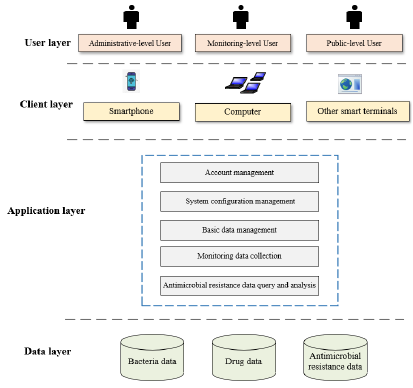
Figure 3. The framework of the system.